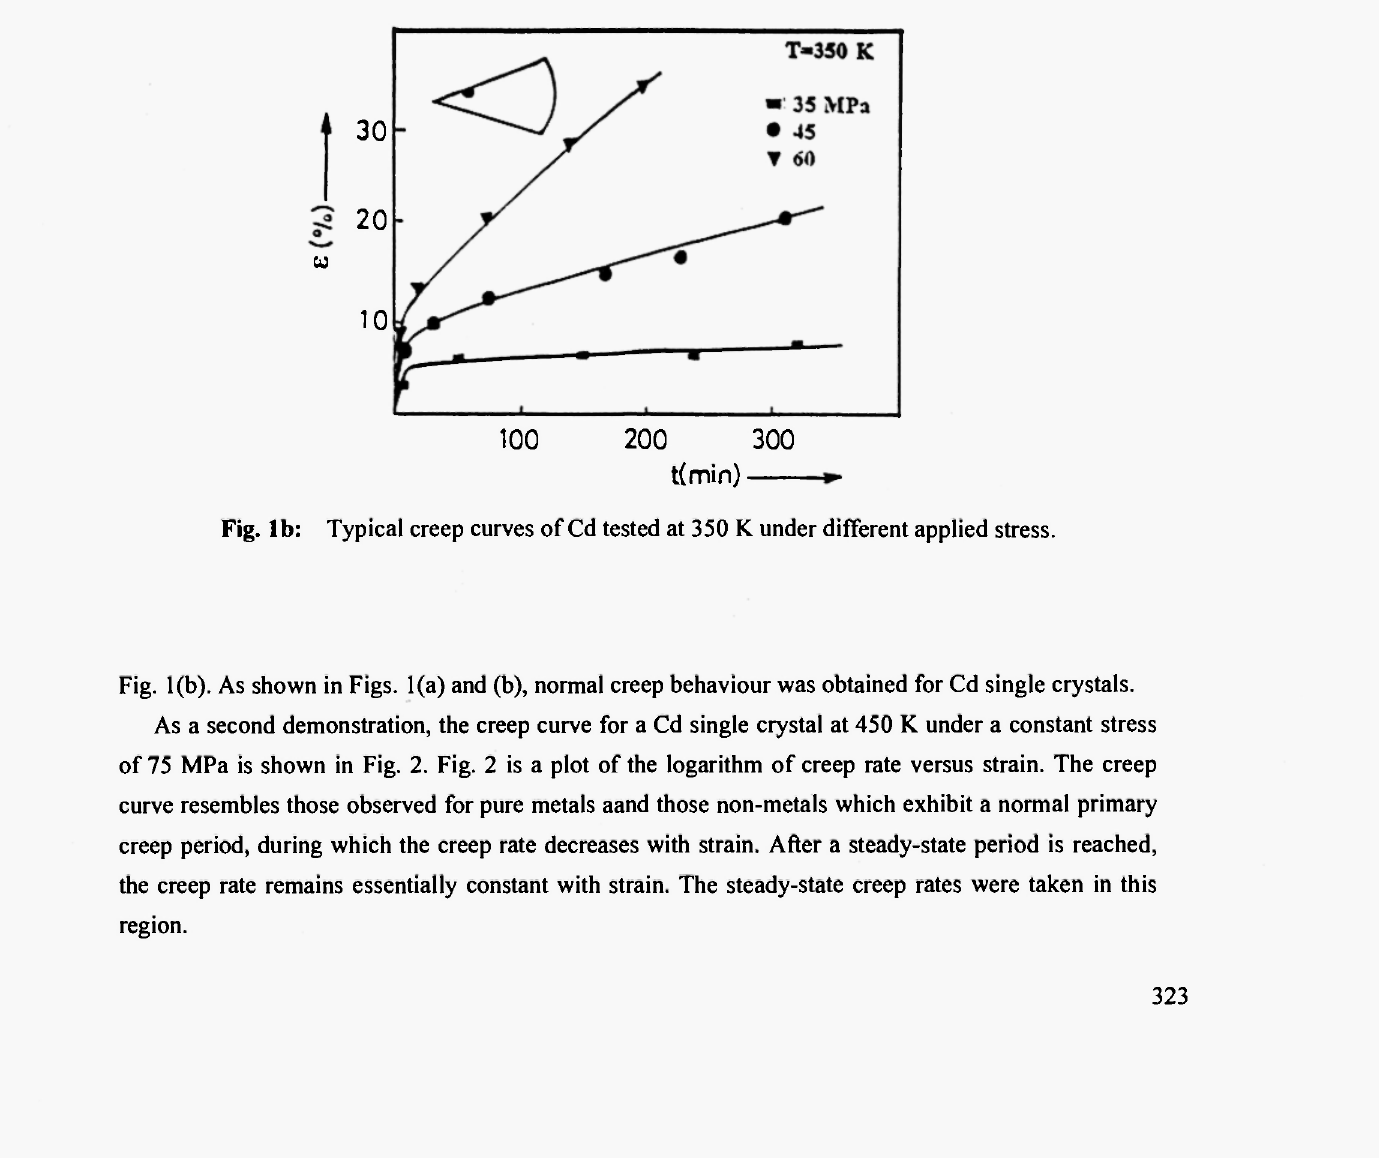
Fig. lb: Typical creep curves of Cd tested at 350 Κ under different applied stress.